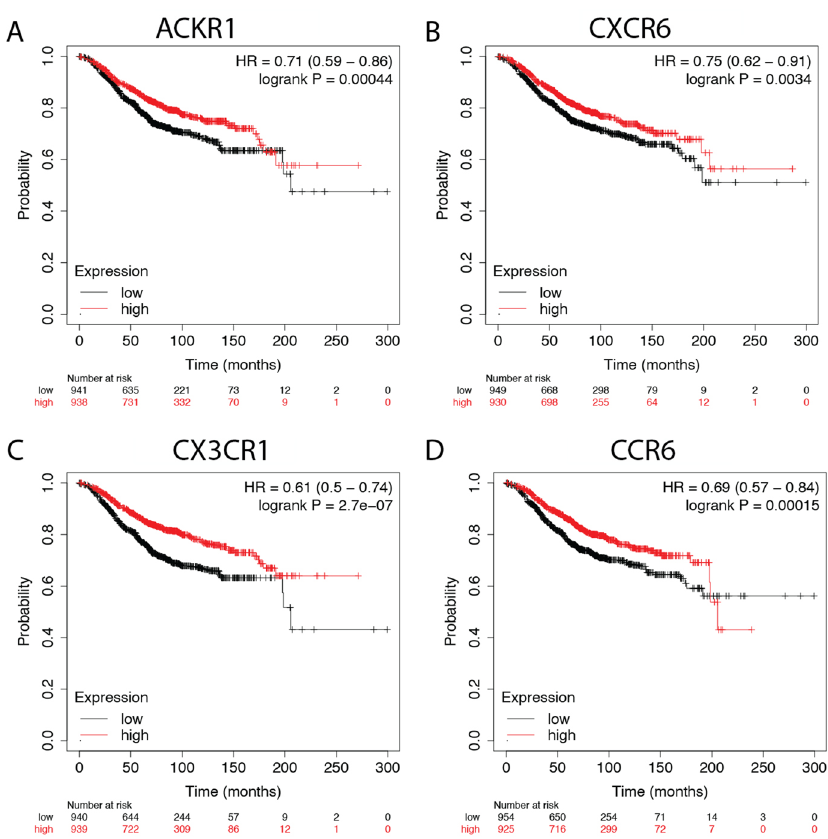
Figure 8. Overall survival rate of breast cancer patients tumor samples. Kaplan–Meier curves of overall survival based on KMplotter mRNA gene chip expression of chemokine receptors in breast cancer patients. Red line represents higher expression and black line represents lower expression. Patients with a high expression of the genes for ( A ) ACKR1, ( B ) CXCR6, and ( C ) CX3CR1 have a higher survival rate than those who have a low expression of the gene. ( D ) CCR6 low expression had better survival only at later time